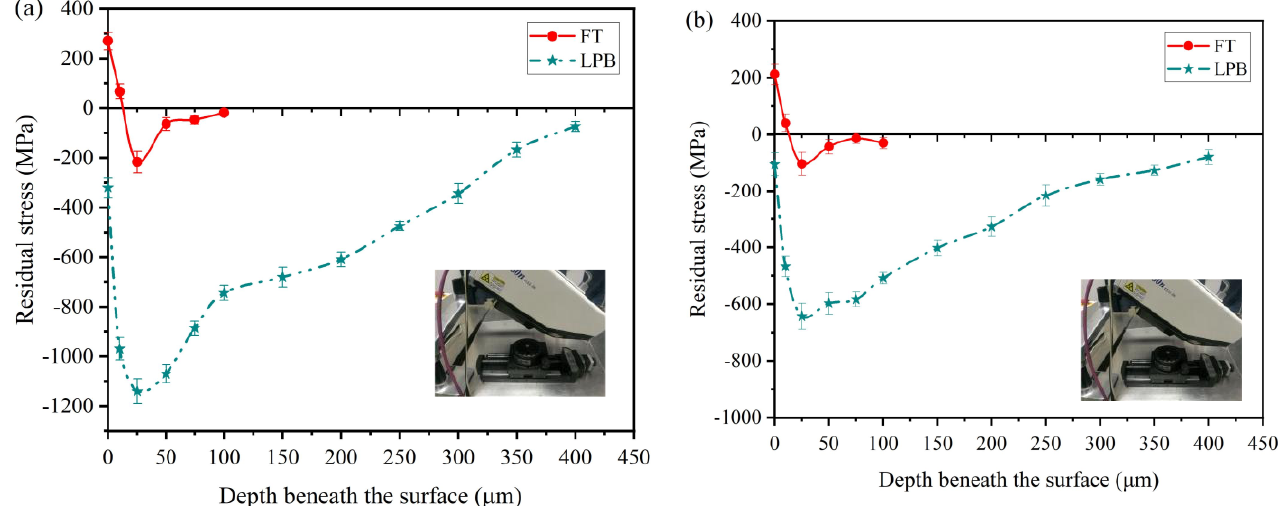
Figure 11. Residual stresses distribution in depth beneath the surface in ( a ) longitudinal and ( b ) transverse directions.